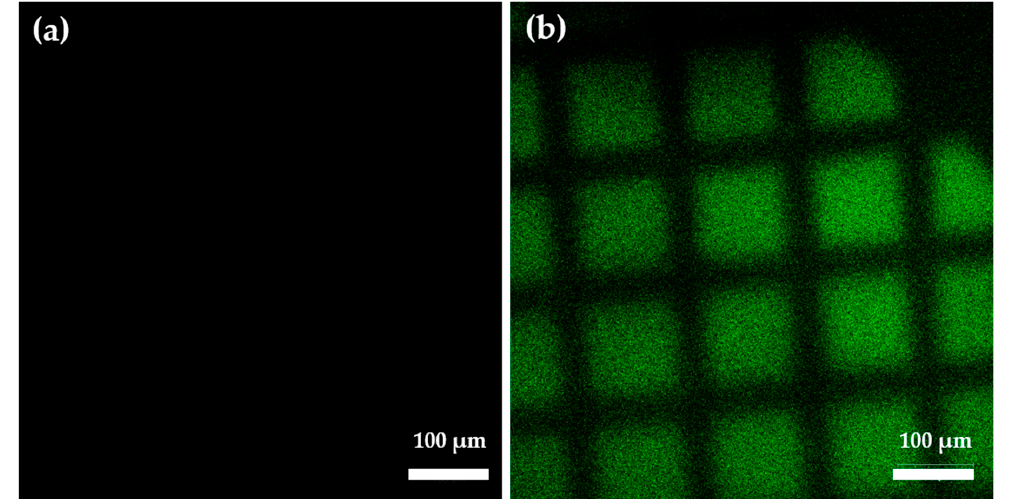
Figure 8. Confocal microscopy images of PEGDA hydrogel ( a ) and PEGDA hydrogel functionalized with Acryl-PEG-Anti-GFP ( b ) stained with Alexa Fluor ® 488 anti-chicken. Scale bars are 100 μ m.